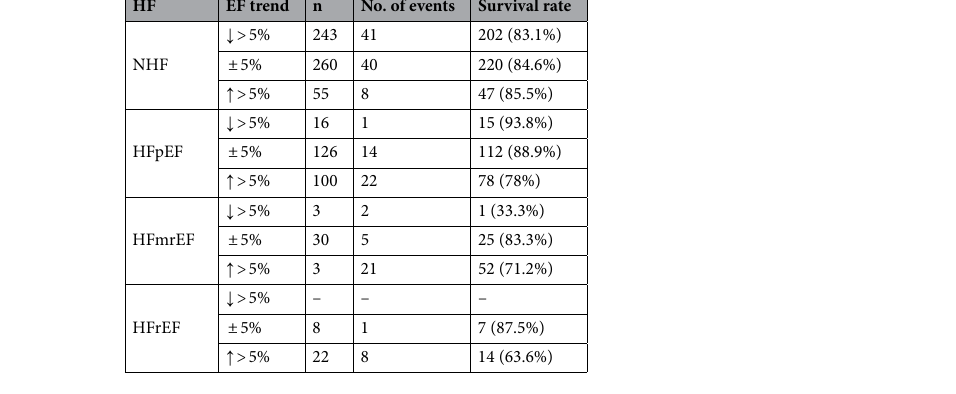
Table 7. EF trend survival rate by HF